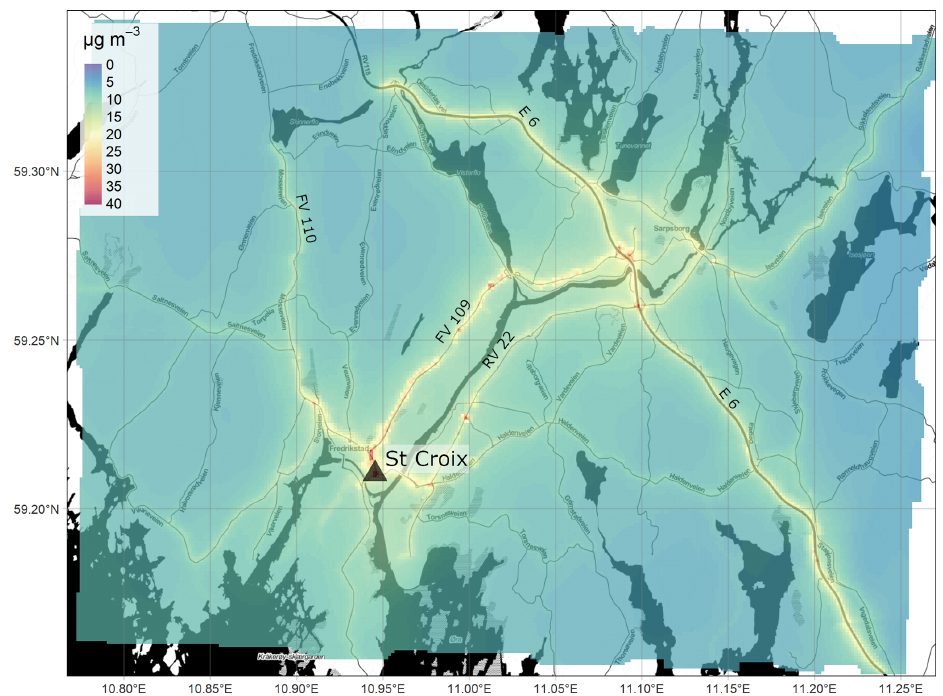
Figure 6. Annually averaged NO 2 concentrations (µgm − 3 ) from the EPISODE model over the Nedre Glomma domain at 100m × 100m horizontal resolution. The concentrations are derived from the receptor point concentrations and then re-gridded onto a 100m grid. The colour scale shows the range in annual mean NO 2 concentrations between 0 and 40µgm − 3 . The black triangles indicate the locations of the air quality observation stations (Table 7). The dark shaded areas represent the sea, lakes, and rivers. The black lines are roads. © OpenStreetMap contributors 2019. Distributed under a Creative Commons BY-SA License.